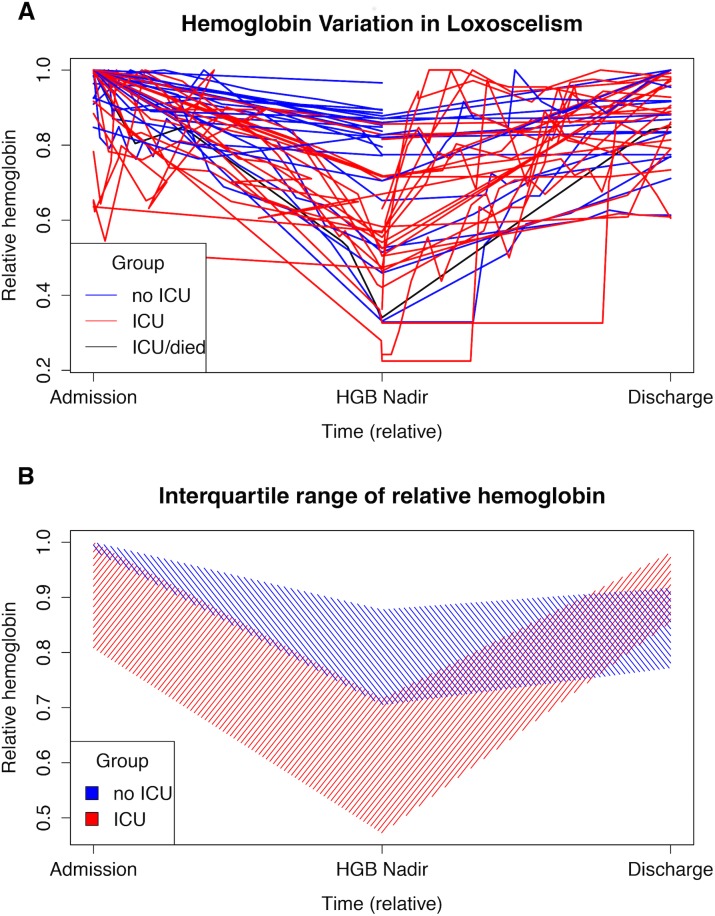
Hemoglobin Fluctuation During Loxoscelism.(A) Each line represents one individual with time and hemoglobin (HGB) graphed relative to the time point at the lowest HGB level (HGB Nadir) and the highest recorded HGB for each individual. Most HGB levels decline after admission and return to baseline. (B) ICU patients have lower interquartile ranges of HGB at presentation and at the HGB nadir, as compared to non-ICU patients. By the time of hospital discharge, the relative HGB level is similar between the two populations.